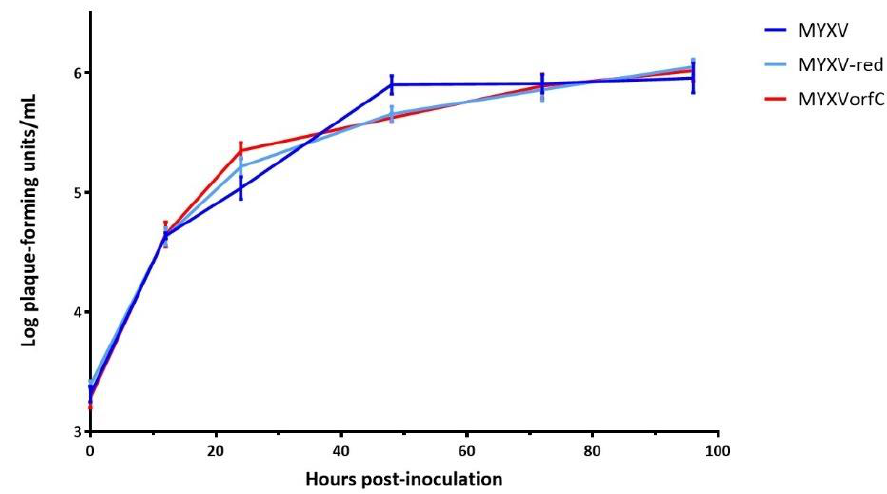
Figure 3. Virus growth curves. Data points represent the average of ten replicates. No significant differences were observed in the growth of wild-type MYXV, MYXV-red, or MYXVorfC (moi = 0.1, error bars = SEM).